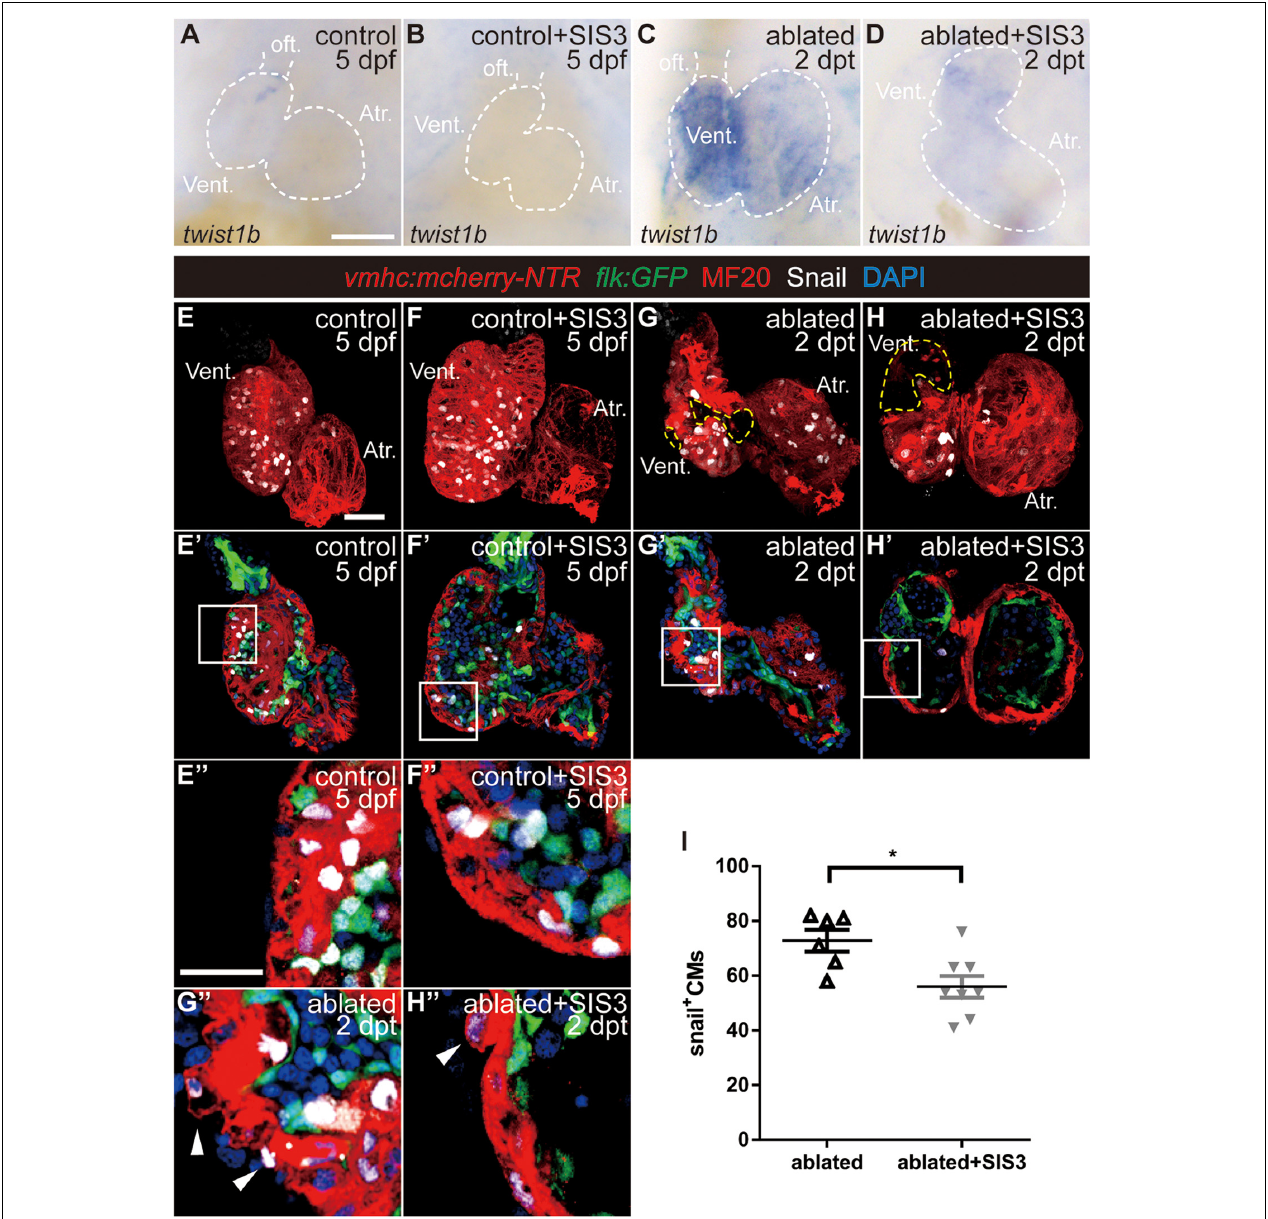
FIGURE 5 | Smad3 inhibition reduces twist expression and Snail-positive CM number during regeneration. (A–D) Whole-mount in situ hybridization showing the expression level change of the EMT marker twist1b during regeneration. Smad3 inhibition via SIS3 treatment reduced the upregulation of twist1b at 5 dpf/2 dpt. Dashed lines outline the hearts. (E–H (cid:48)(cid:48) ) Representative fluorescent images of Tg(vmhc:mCherry-NTR; flk:GFP) hearts with immunostaining of Snail (white), MF20 (red), and DAPI (blue) in the control or ablated hearts without or with SIS3 treatment at 5 dpf/2 dpt. (E–H) Maximal projections of z-stack images, overlay of red and white channels; yellow dashed lines outline the ablated area. (E (cid:48) –H (cid:48) ) Optical sections of panels (E–H) , overlay of four channels. (E (cid:48)(cid:48) –H (cid:48)(cid:48) ) Enlargement of box area in panels (E (cid:48) –H (cid:48) ) ; arrowheads point to extruding Snail + CMs into the outer layer. (I) Quantification of Snail + CM number in the ablated hearts without or with SIS3 treatment at 5 dpf/2 dpt. N = 6 and 8, respectively. Mean ± s.e.m., Student’s t -test, two-tailed, * P < 0.05. Scale bars, (A–D) 50 µ m, (E–H (cid:48) ) 20 µ m, and (E (cid:48)(cid:48) –H (cid:48)(cid:48) ) 10 µ m. dpf, days post-fertilization, dpt, days post-treatment; atr., atrium; oft., out flow tract; vent., ventricle; CM, cardiomyocyte; EMT, epithelial–mesenchymal